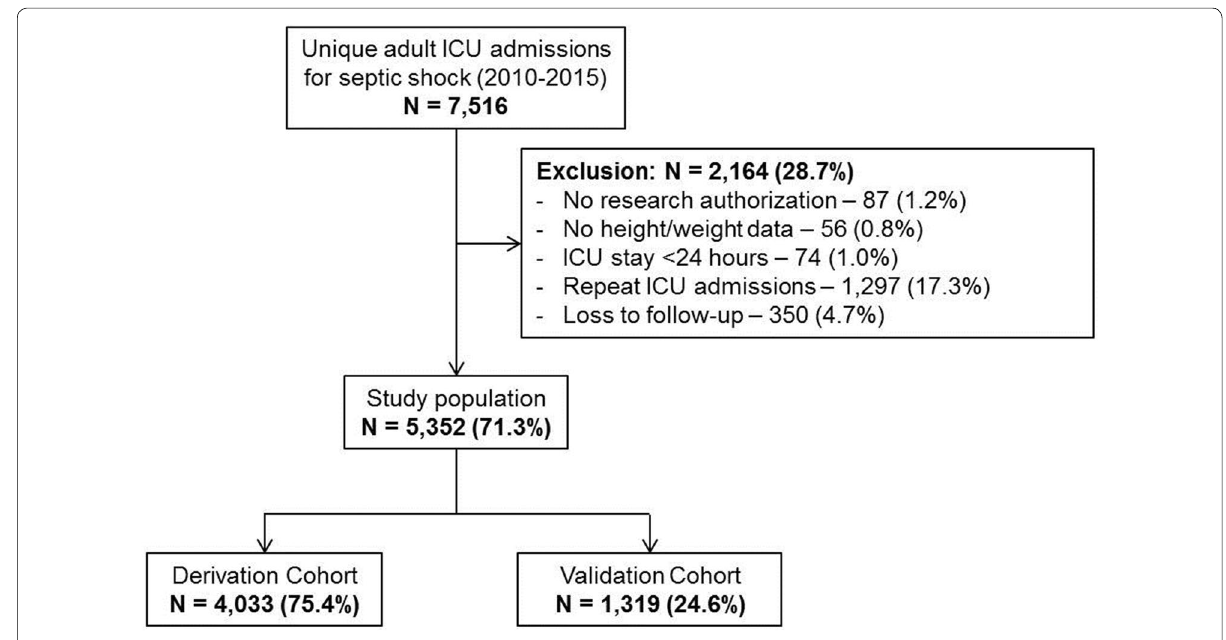
Fig. 2 Study population. ICU intensive care unit